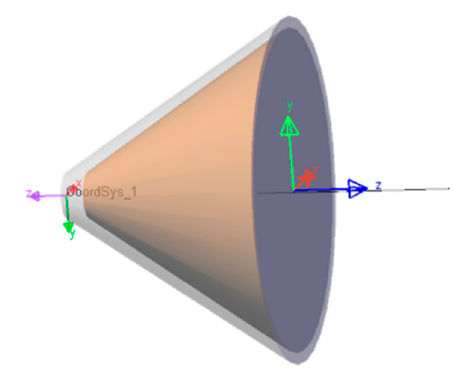
Figure 10. LightTools 3D Model of an LED cone with internal conical emitting layer.